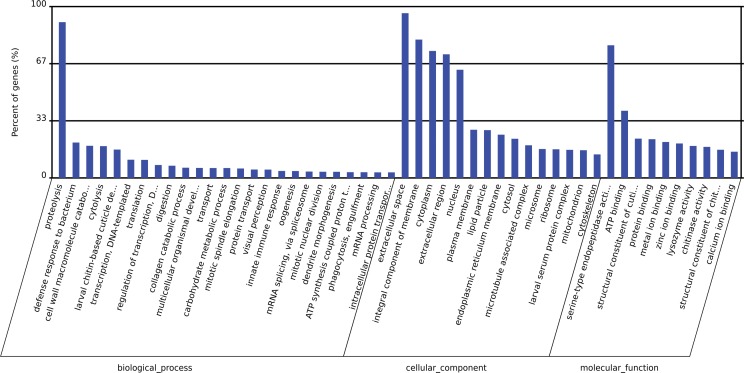
GO classifications of unigenes derived from sequencing miRNAs in B. dorsalis.The terms were summarized into 3 main GO categories and 50 sub-categories. The y-axis represents the percentage of unigenes.